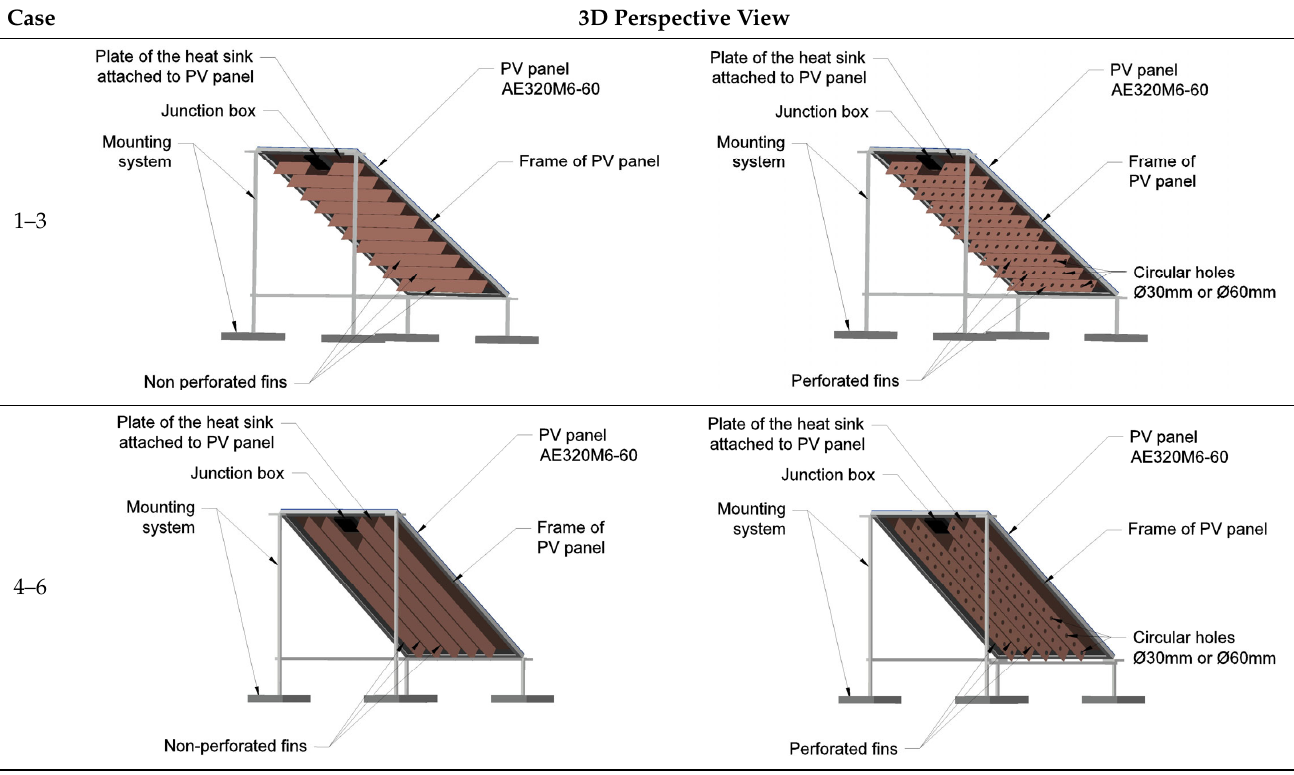
Table 4. The perspective view of the heat sinks attached to the PV panel.